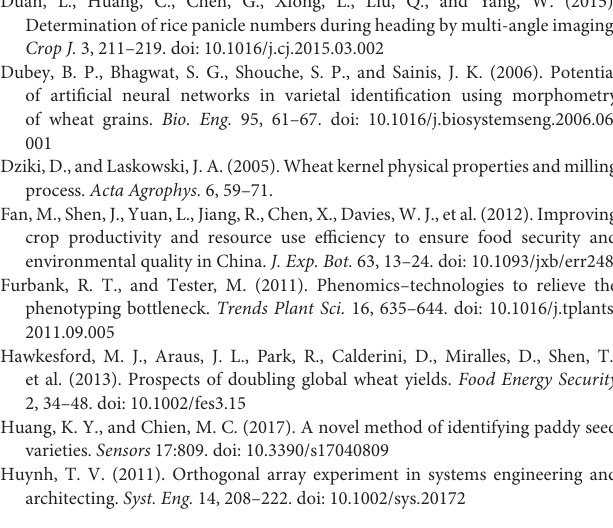
Supplementary Table 3 | The original data of five grain weight prediction models using 500 wheat grains. Supplementary Video 1 | Introduce the use of the wheat 3D traits extraction software. Supplementary Appendix 1 | Parameters of X-ray source and